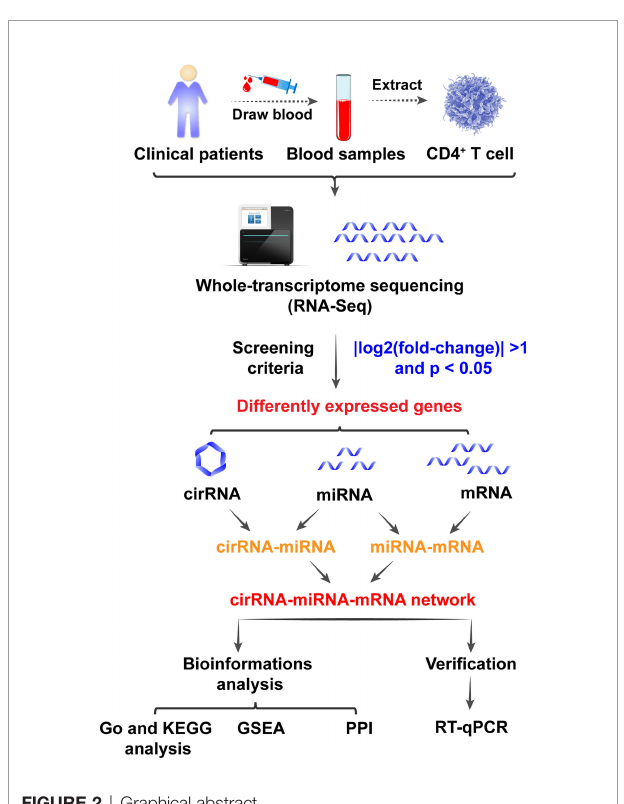
FIGURE 2 | Graphical and circRNAs are displayed using Volcano plot ( Figure 3A ) and